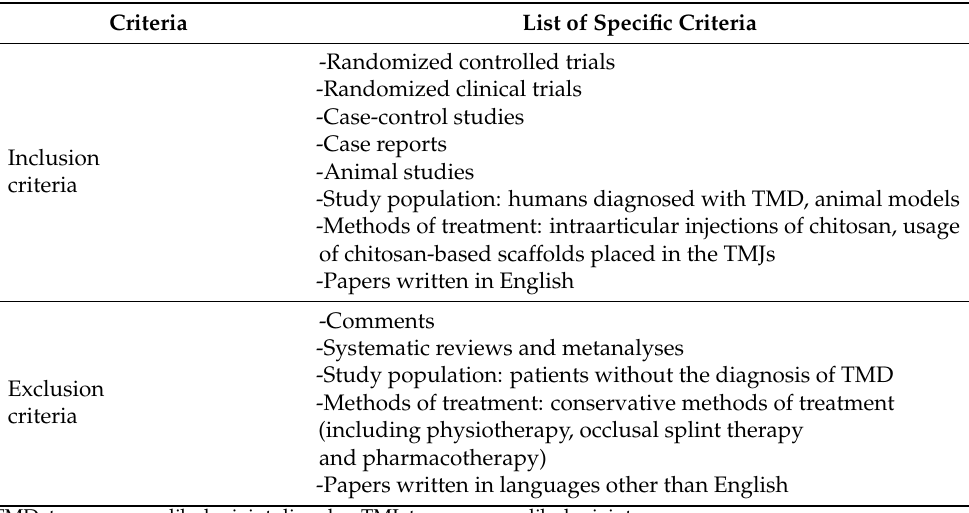
Table 1. Inclusion and exclusion criteria used for the narrative